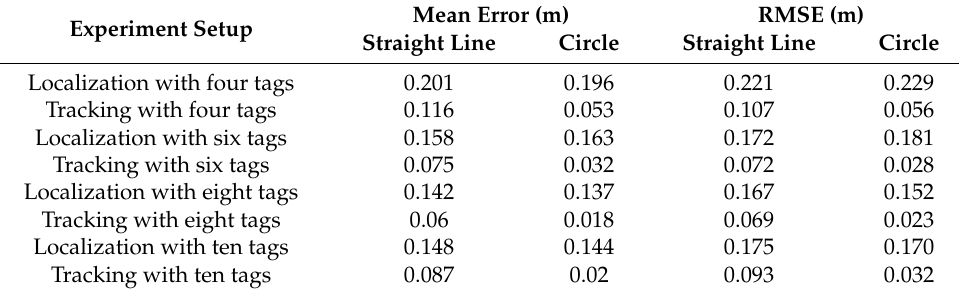
Figure 6. The CDF curves of the circle trajectory tracking error with different numbers of tags. Table 1. Ranging and localization mean